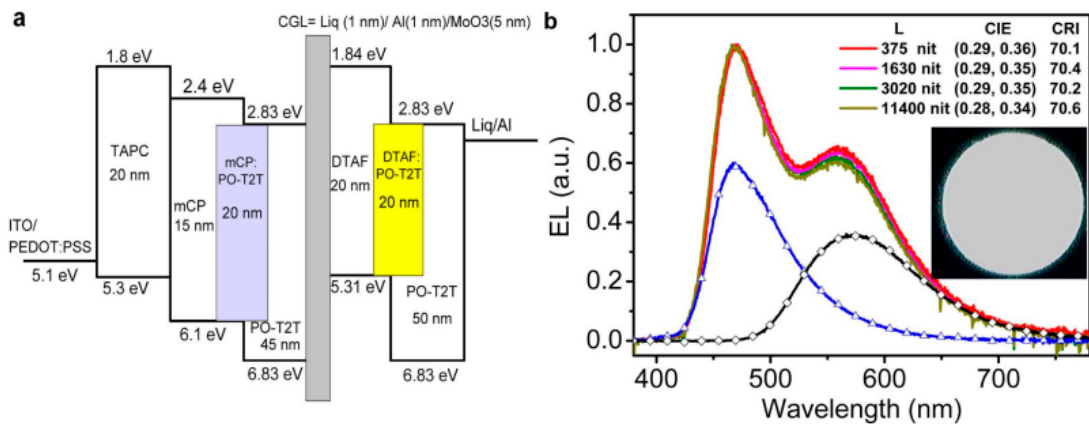
Figure 3. ( a ) The electronic level configurations of tandem WOLED. ( b ) EL spectra of the WOLED at different brightness, and two decomposed bands corresponding to the blue and yellow exciplex emissions [165].